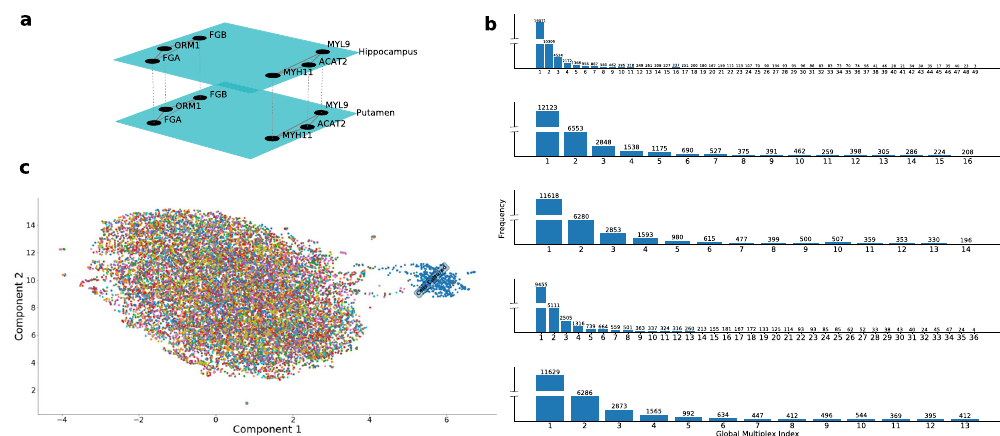
Fig. 6 Multiplex analysis. a An example of a multiplex network in "Brain Hippocampus'' and "Brain Putamen'' (basal ganglia). Each layer denotes a tissue, and nodes are the genes, which are connected via the interlayer connections. In the multiplex example, we see the presence of two communities. These two communities are indeed part of the "Brain Tissues'' multiplex architecture, present in all 13 layers (brain regions). All genes in the community { FGA , ORM1 , FGB } have been implicated as biomarker and therapeutic targets for intracerebral hemorrhage. b Histograms show the empirical distribution of the global multiplexity index for each multiplex architecture (with positive index). The index quanti fi es how many times two genes belong to the same communities across layers. The proportion at each value k of the index is an estimate of the π k (see “ Methods ” section). The maximum value corresponds to the number of layers or tissues of the multiplex network. Histograms, from the top, correspond to: all tissues, brain and gastrointestinal tissues, brain tissues and whole blood, non-brain tissues, brain tissues. c We performed UMAP on the subset of communities that exist across all layers of the central nervous system ("Brain Tissues'') multiplex. This set does not yield complete clustering of